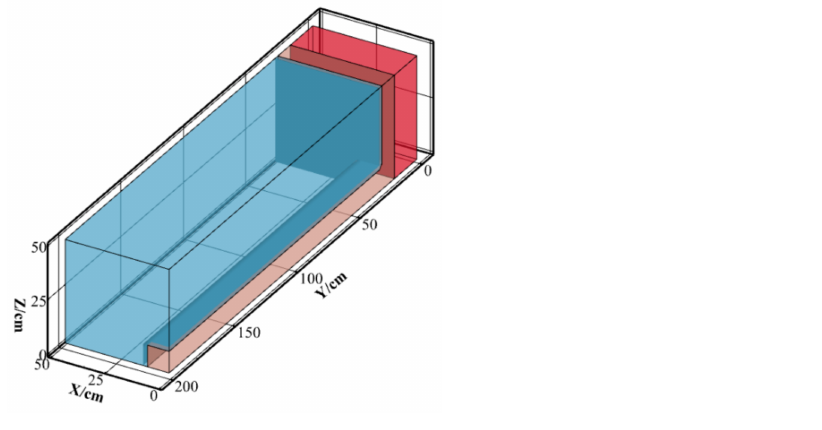
Figure 3. Computational model of the self-designed neutron streaming problem.